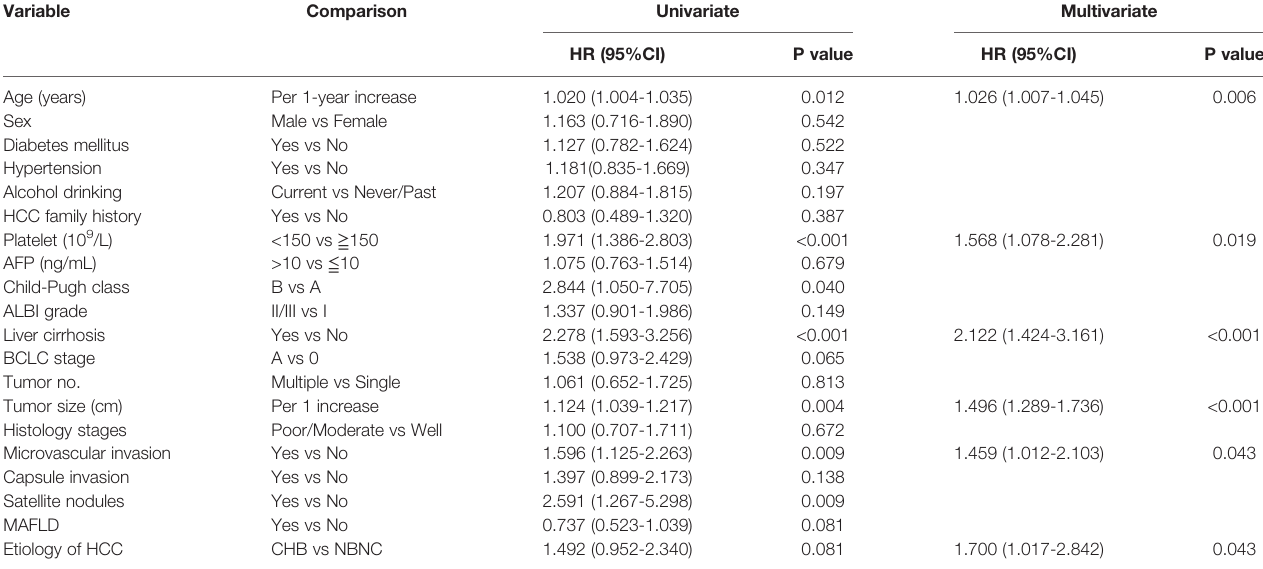
TABLE 4 | Prognostic factors associated with overall mortality.